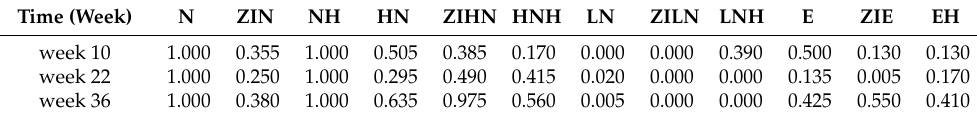
Table A2. KS-test p values for pregnant group ( N = 22) under 12 distributions at different